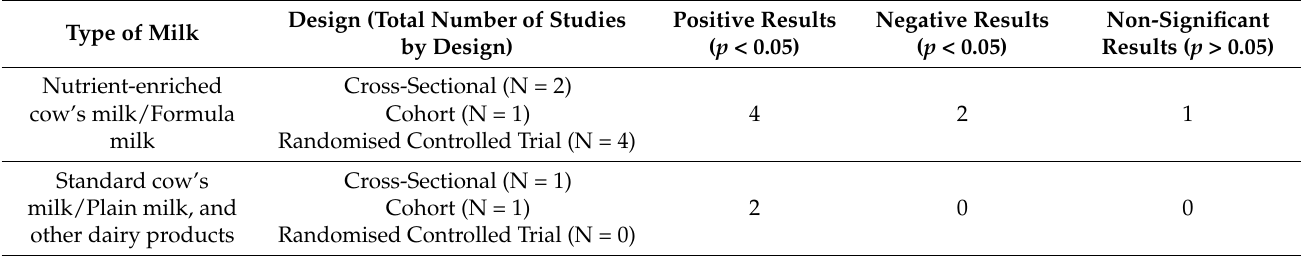
Table 7. Different types of milk and the